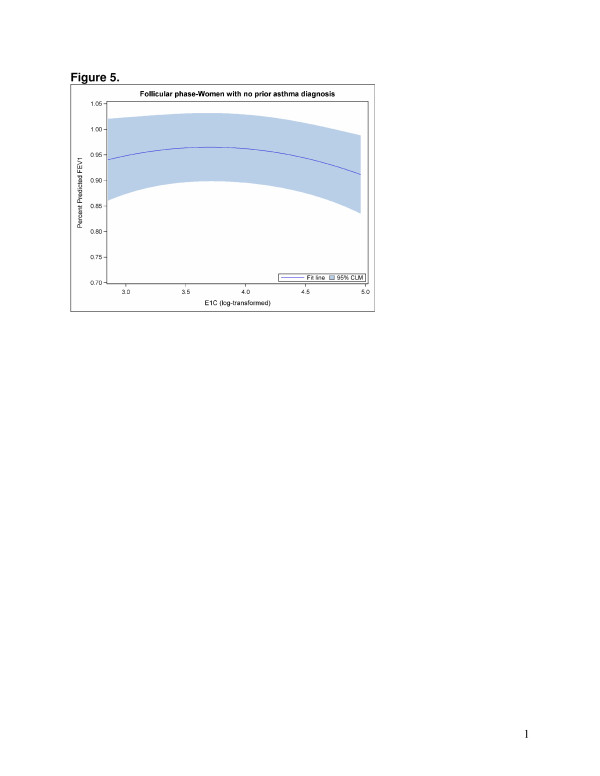
The log of PDG hormone level (x axis) associated with percent predicted FEV1 (y axis) in the follicular phase among women with no prior asthma diagnosis. For purposes of illustrating the relationship between log PDG and FEV1, menstrual segment day is held constant at 7 days prior to ovulation.